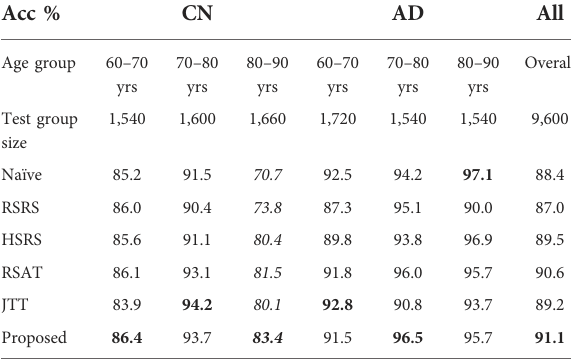
TABLE 2 Average test accuracies of models trained via our procedure and